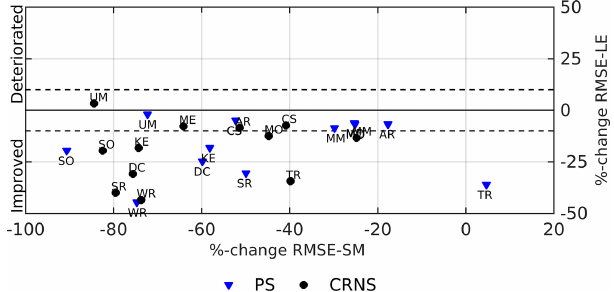
Figure 8. Relative change in RMSE values after two-objective cal- ibration against (1) PS soil moisture and latent heat flux and (2) against CRNS neutron count data and latent heat flux. Change in RMSE between observed and simulated latent heat flux (LE) is plot- ted against change in RMSE between observed and simulated soil